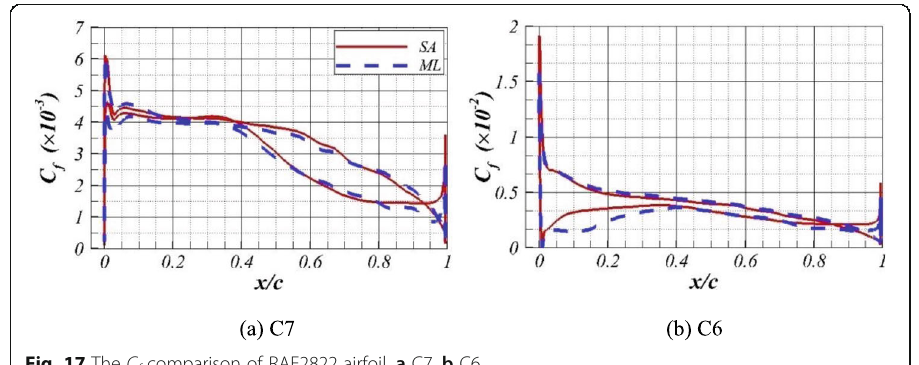
Fig. 17 The C f comparison of RAE2822 airfoil. a C7. b